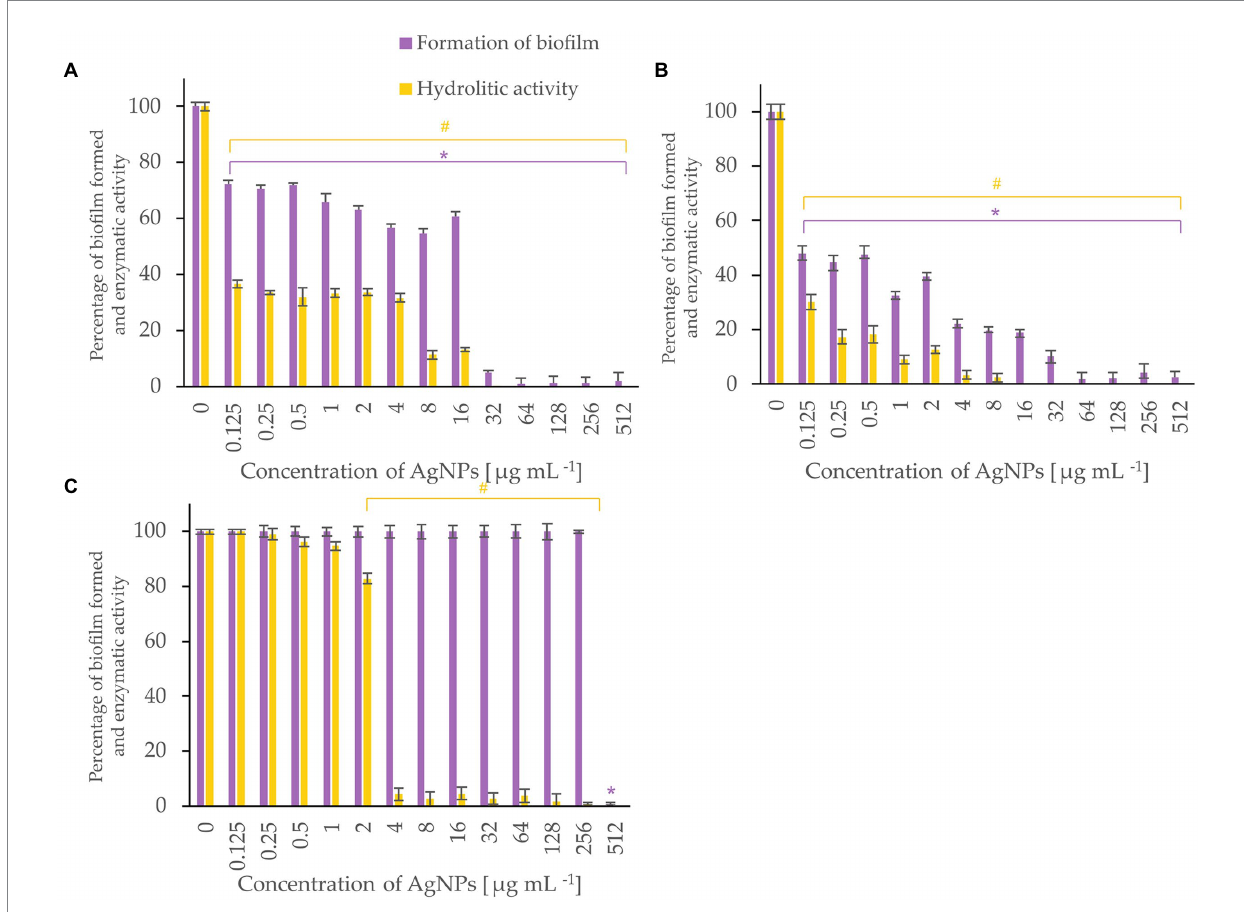
FIGURE 6 Percent of bacterial biofilm formation and hydrolase activity in biofilms after treatment with various concentrations of AgNPs from F. culmorum strain JTW1. Listeria monocytogenes (A) , Salmonella enterica (B) , S. infantis (C) . The statistical significance (value of p < 0.05) of tested variants (different concentrations of AgNPs) compared with untreated control were indicated by * and # signs for biofilm formation and hydrolytic activity tests,